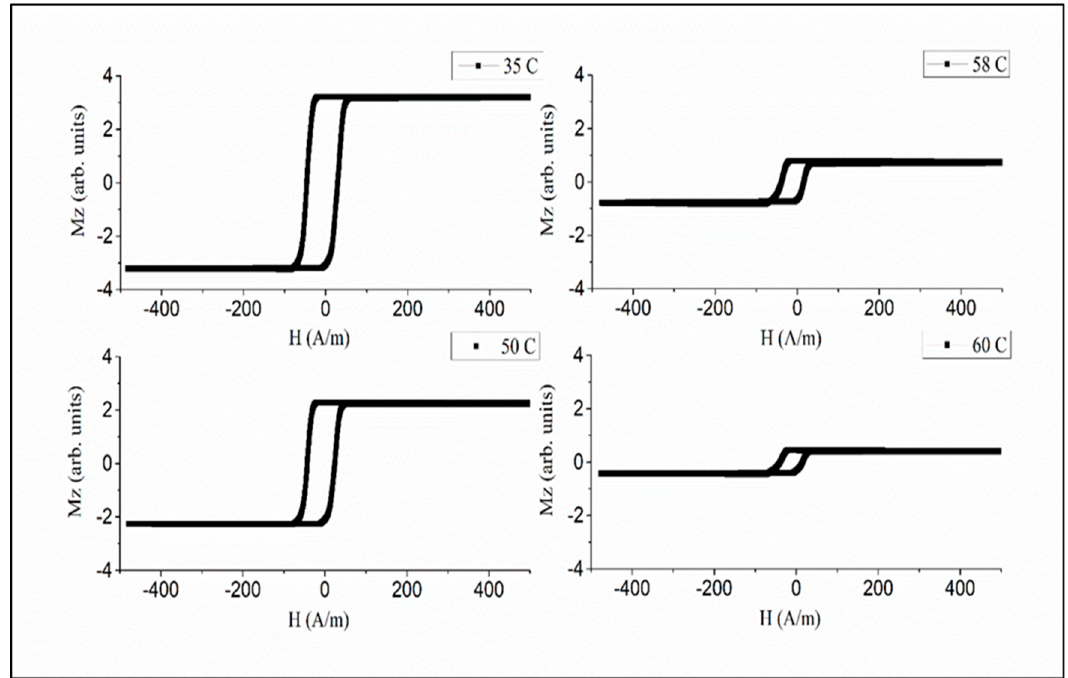
Figure 8. Magnetization loops of glass-coated Fe 3.9 Co 64.82 B 10.2 Si 12 Cr 9 Mo 0.08 microwires for different temperatures, including near T C = 62 °C obtained by the induction method. The loops are normalized by the saturation value at room temperature. The wire had the total diameter of 27.3 µm and the metallic core diameter of 17.7 µm.